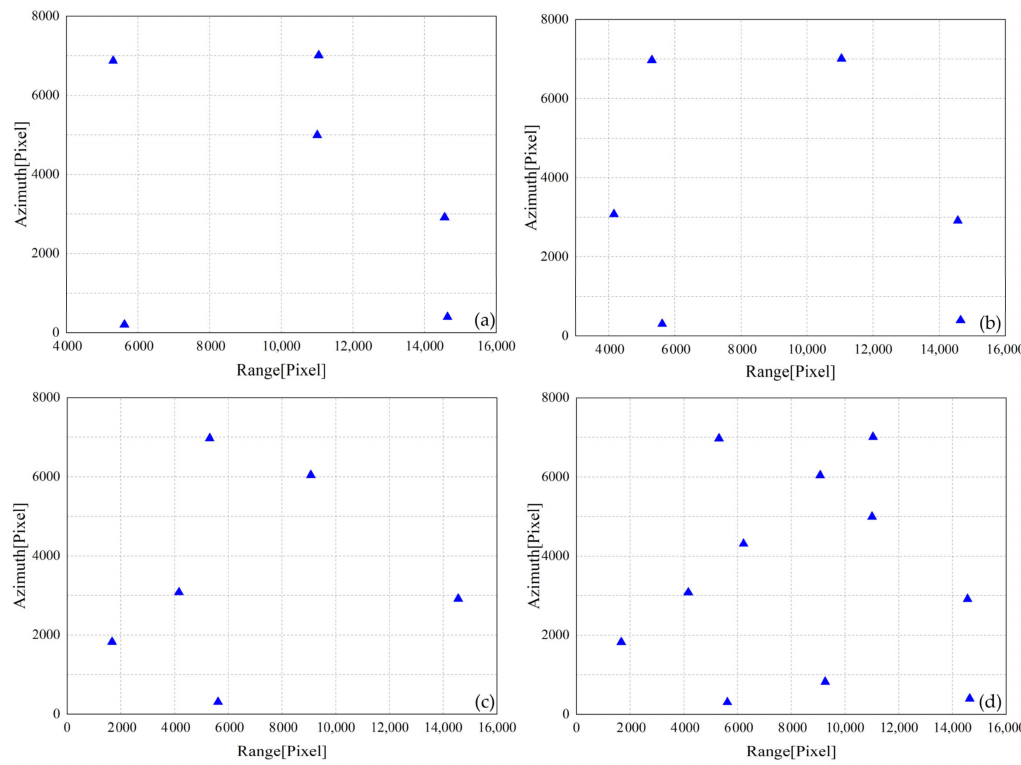
Figure 4. Four GCP layout schemes considered herein: ( a ) denotes the distribution of the 6 points along the azimuth direction, ( b ) denotes the distribution of the 6 points along the range direction ( c ) and ( d ) denote the distribution of 6 and 11 points along the random direction, respectively. Where the blue triangles represent the GCPs.